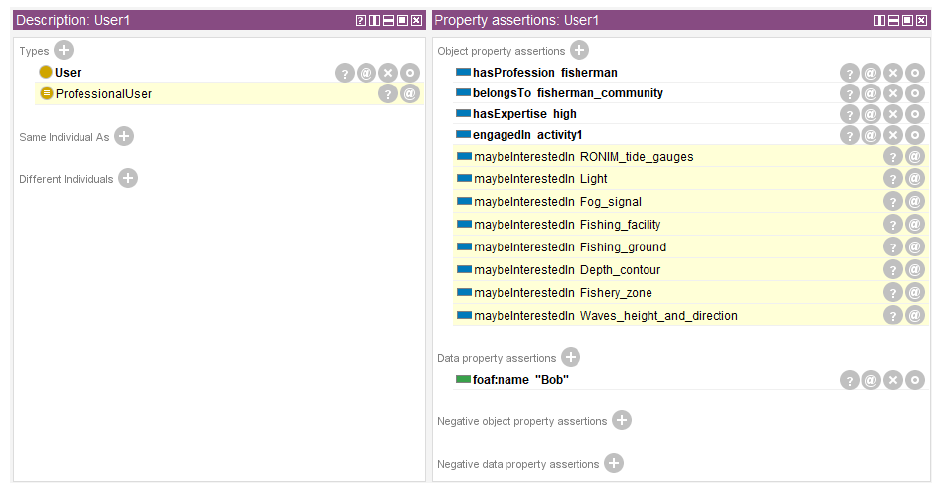
Figure 6. Results of inferences for scenario 1 using Protégé . Recommendation of thematic layers for Bob’s on-demand